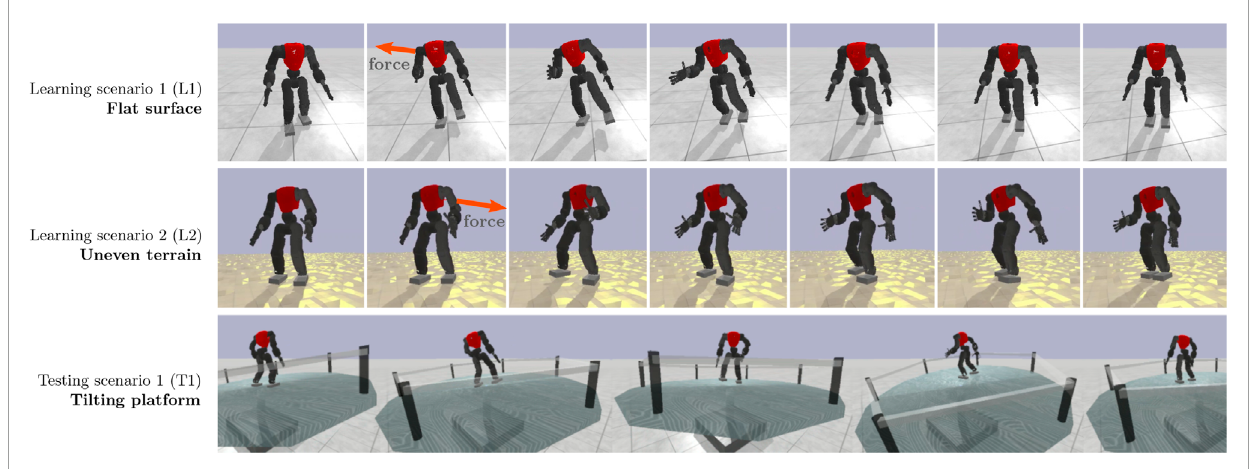
FIGURE 4 Illustration of learning scenarios: (1) a flat surface where the robot learns how to recover from external forces ( L1 ); (2) an uneven terrain with vertical heights of 2 cm ( L2 ); (3) Unseen scenarios on a tilting platform that moves erratically ( T1 ).